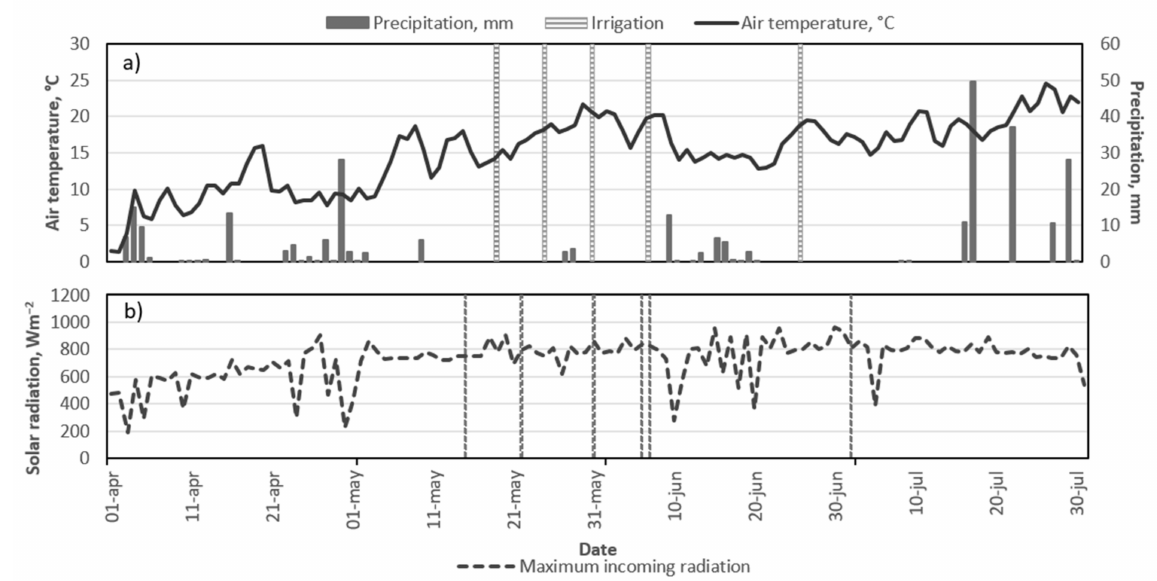
Figure A2. Mean daily temperature, precipitation and irrigation ( a ), as well as the mean daily solar incoming radiation and flight days ( b ), for the seasonal field experiments with winter wheat in 2018 in Denmark. Vertical lines indicate the time of the UAS flights. In 2019, only the diurnal field campaign was conducted (see Figure A1).